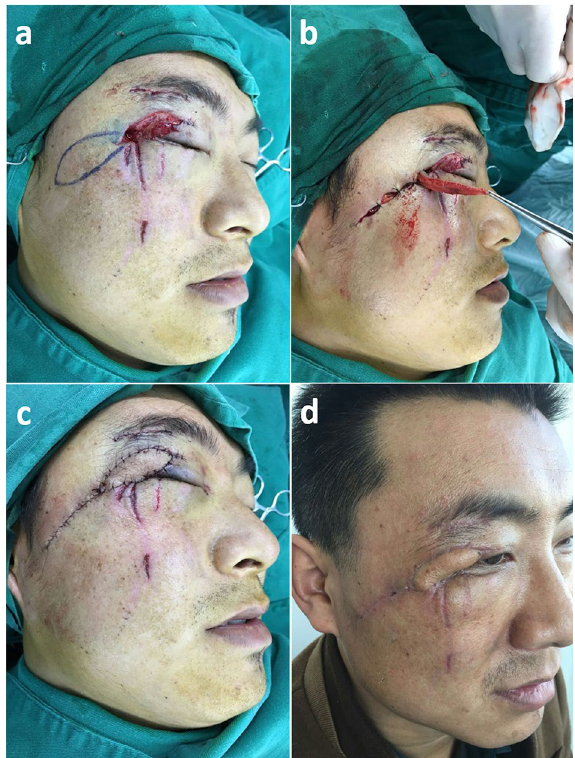
Figure 4. ( a ) A 49-year-old man had a large defect of upper eyelid due to car accident. ( b , c ) After a thorough debridement, the subcutaneous pedicled propeller flap was designed to reconstruct the large defect. (d) After postoperative 1 week, the sutures were removed and the wound healed